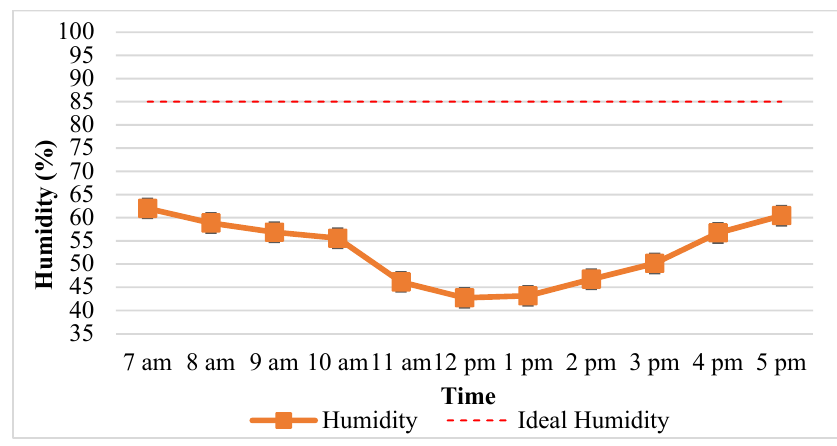
Figure 4. Greenhouse humidity without the misting system.